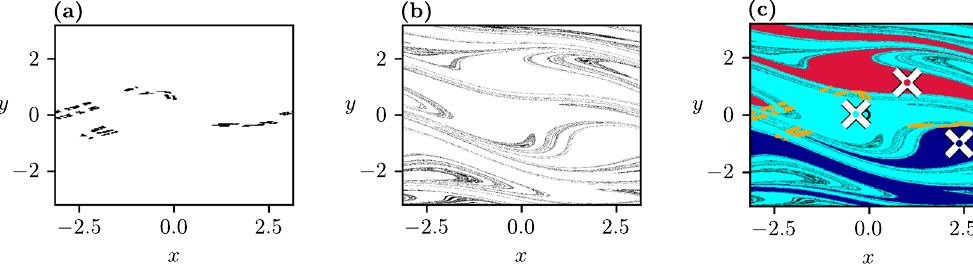
Figure 4. ( a ) Chaotic saddle existing in the frozen-in system at C = 0.33. ( b ) Stable manifold of the saddle. Both objects are determined by the sprinkler method as described in 41,42 . ( c ) The saddle (yellow dots) and its stable manifold laid over the basins of attraction in the frozen-in system, with C + (Fig.